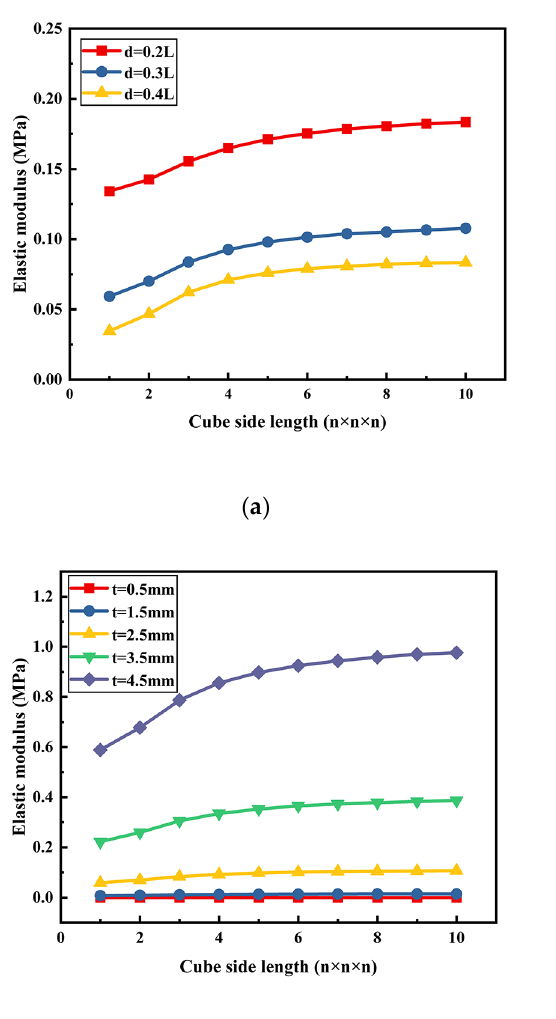
Figure 11. The deformation mechanism diagram and different geometric parameters of the auxetic unit cell: ( a ) Deformation mechanism of the auxetic cell under an external load; ( b ) Different concave depths of the auxetic cell (L = 70 mm); ( c ) Shematic diagram of the beam section size of the auxetic cell